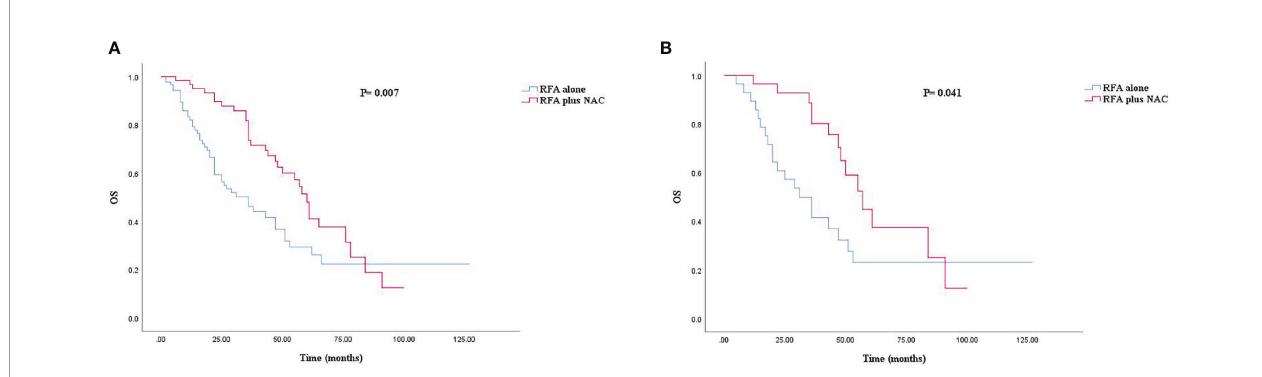
FIGURE 3 | Kaplan – Meier survival curve for OS of the RFA alone and plus NAC groups. (A) Unmatched analyses and (B) propensity-score-matched analyses.